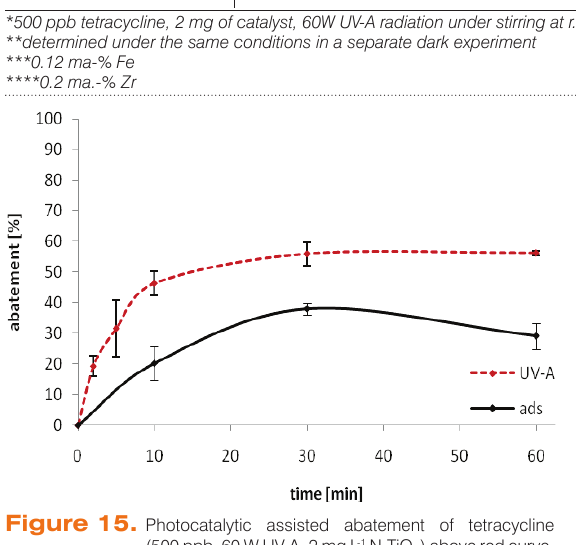
Figure 15. Photocatalytic assisted abatement of tetracycline (500 ppb, 60 W UV-A, 2 mg L -1 N-TiO contribution of adsorption below black curve.